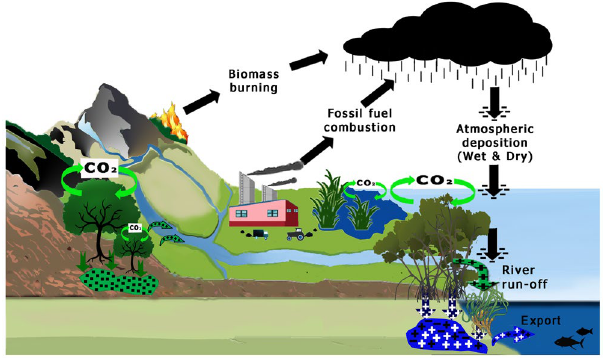
Figure 1. An augmented blue carbon conceptual model. The model shows the ability of saltmarsh, mangrove, and seagrass canopies to trap and store black pyrogenic carbon (BC) washed out from the catchment (green and black) and atmosphere (black), along with detritus produced by those coastal vegetated ecosystems (blue and black). BC is resistant to oxidation, and we argue that failure to remove BC and other types of allochthonous recalcitrant organic carbon, such as kerogens, from calculations of coastal vegetated habitat sedimentary carbon stocks could result in overestimated values used to estimate the mitigation service provided by these stocks in terms of anthropogenic emissions of CO 2 . Icon credit: Tracey Saxby (mangrove) and Catherine Collier (seagrass), Integration and Application Network, University of Maryland Center for Environmental Science